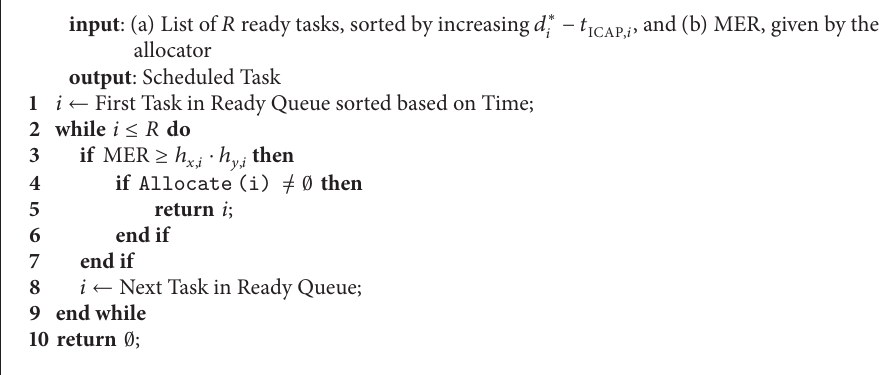
Algorithm 1: Schedule EDF() .